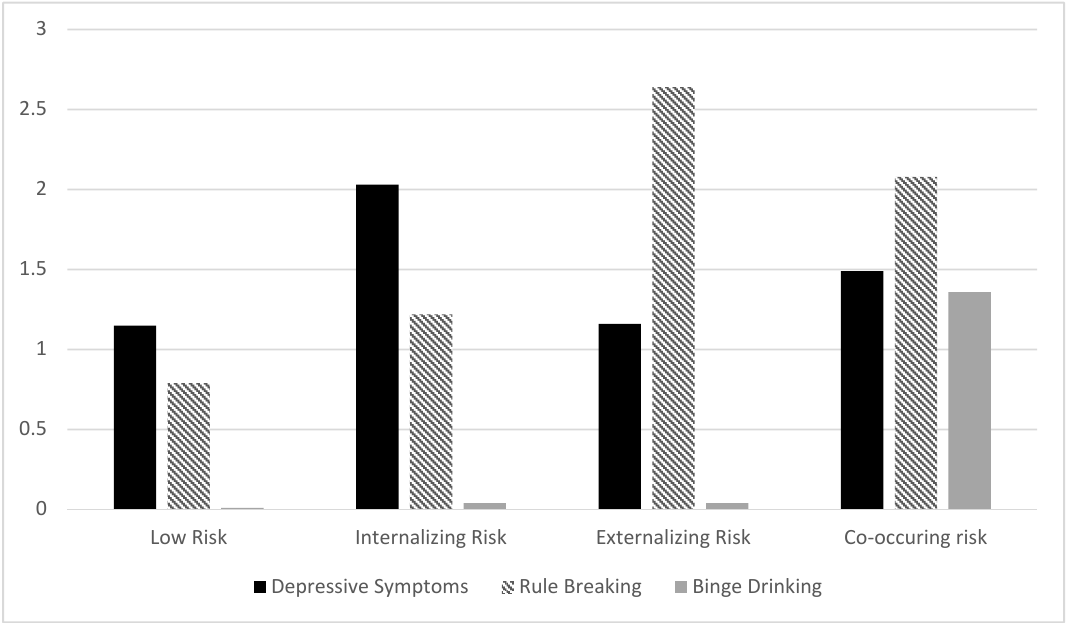
Figure 1. Unstandardized means of adjustment profile indicators.